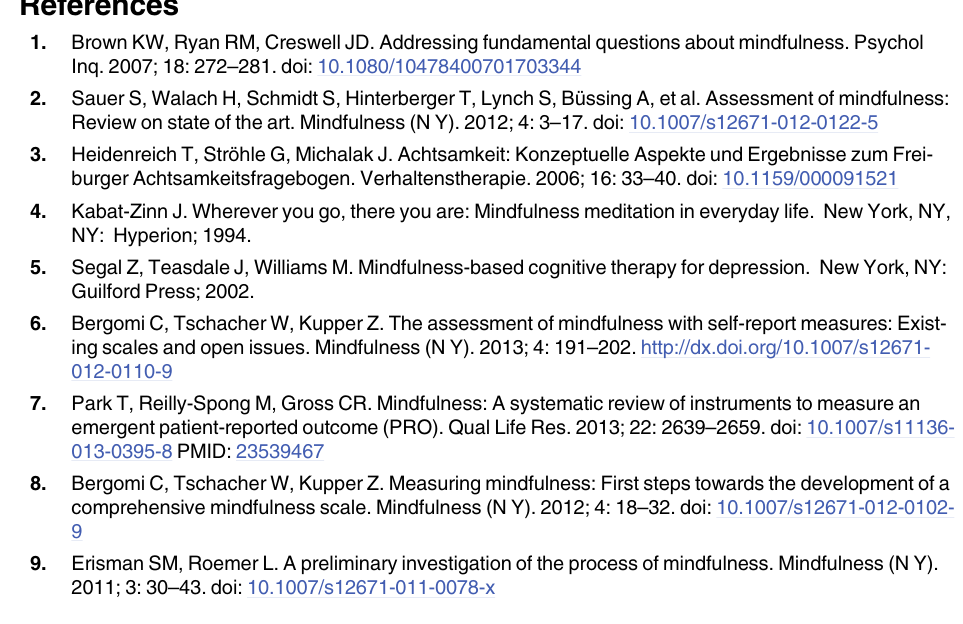
S1 Table. Pattern Matrix for Promax Eight-Factor Solution Extracted from FFMQ, TMS, and PHLMS Item Parcels Corresponding to Each Facet or Subscale and Factor Correlation Matrix in Sample